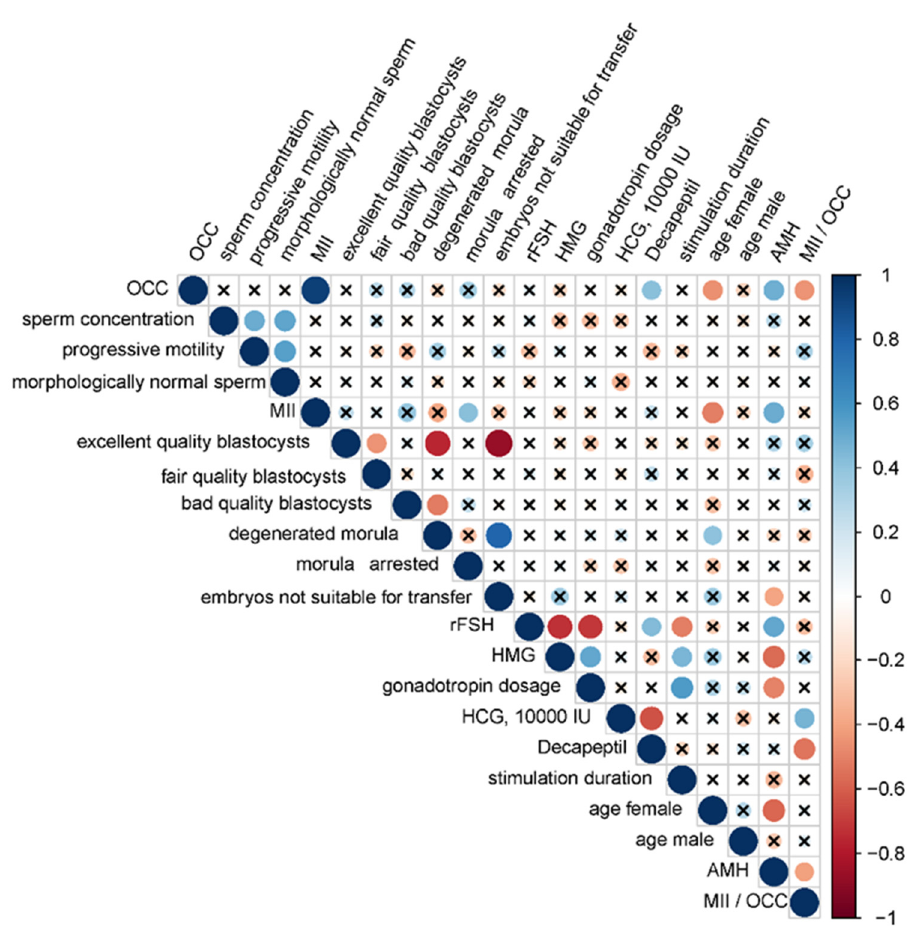
Figure 1. Correlation matrix based on the nonparametric Spearman rank correlation method. Significant ( p < 0.05) correlations are indicated by a dot, nonsignificant correlations are indicated by a cross, positive correlations are marked in blue, and negative correlations in red: the more significant the correlation, the larger the dot size. Parameters used in correlation analysis: OCC—the number of oocyte–cumulus complexes from the female of each couple; sperm concentration—spermatozoid count per milliliter of ejaculate from the male of each couple; progressive motility—percentage of linearly motile spermatozoids from the male of each couple; morphologically normal sperm—percentage of morphologically normal spermatozoids from the male of each couple; MII—metaphase II oocyte number from the female of each couple; excellent quality blastocysts—percentage of excellent / good-quality blastocysts on day 5 a.f.; fair quality blastocysts—percentage of fair-quality blastocysts on day 5 a.f.; bad quality blastocysts—percentage of bad-quality blastocysts on day 5 a.f.; degenerated morula— percentage of degraded morula on day 5 a.f.; morula arrested—percentage of morula arrested in development on day 5 a.f.; embryos not suitable for transfer—percentage of degraded morula, morula arrested in development and morula developed into a blastocyst of bad quality on day 5 a.f.; rFSH—the use of recombinant follicle-stimulating hormone for ovarian stimulation; HMG—the use of human menopausal gonadotropins for ovarian stimulation; gonadotropin dosage —total dose of gonadotropin used for ovarian stimulation, IU; HCG, 10,000 IU—the use of human chorionic gonadotropin (10,000 IU) for triggering final oocyte maturation; Decapeptil—the use of 0.2 mg decapeptylfortriggeringfinaloocytematuration; stimulationduration—durationofovarianstimulation, days; AMH—the anti-Müllerian hormone level (ng / mL) in blood from the female of each couple; MII / OCC—metaphase II oocyte number as a percentage of oocyte–cumulus